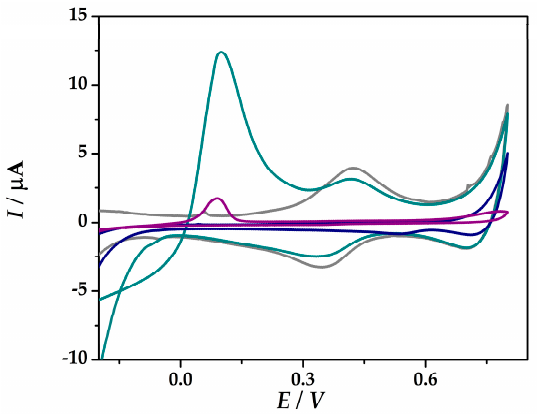
Figure 2. CVs recorded at ( IV )Au-PtNPs / SPCE in 0.1 M HCl (blue), in the presence of 1 mM As(III) in 0.1 M HCl (purple), and at ( VI )Au-PtNPs / PANI / SPCE in 0.1 M HCl (grey), in the presence of 1 mM As(III) in 0.1 M HCl (dark cyan) at 50 mV s − 1.